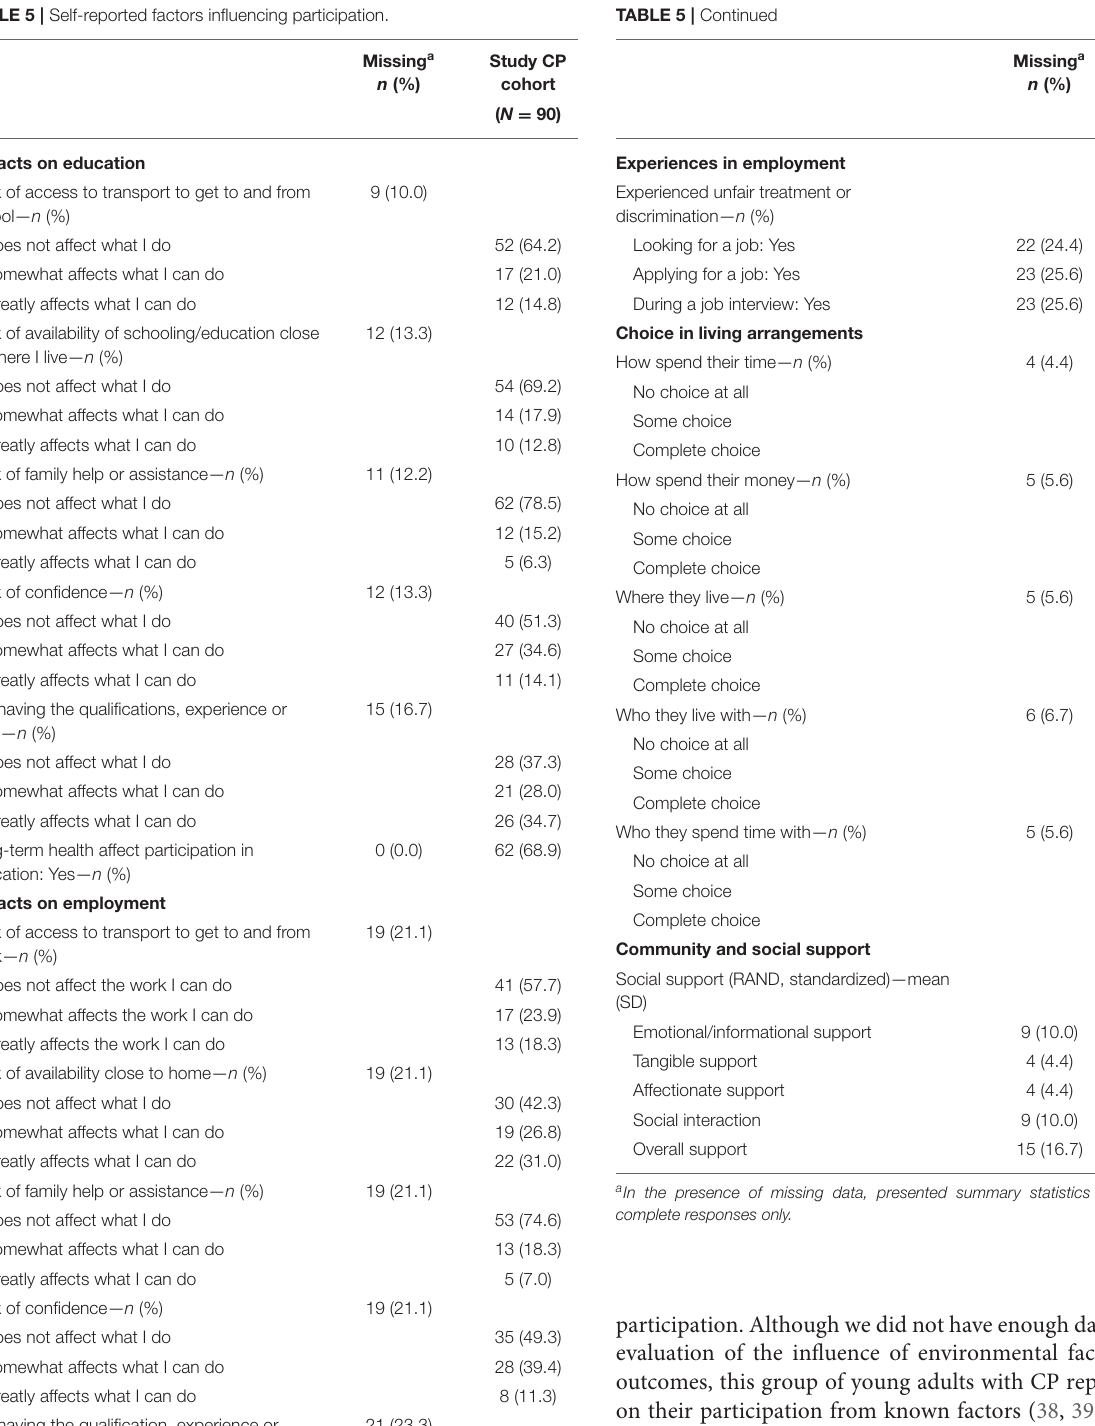
TABLE 5 | Self-reported factors influencing participation.